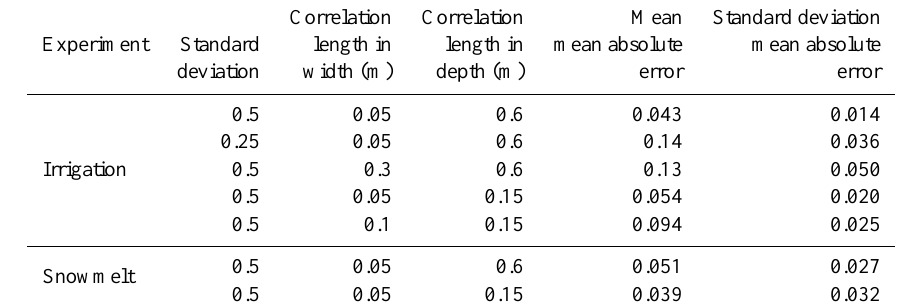
Table 1. Mean and standard deviation of the mean absolute error between observed and simulated sorted and cumulated drainage of five realisations, for the irrigation experiment and the snowmelt experiment. Correlation Correlation Mean Standard deviation